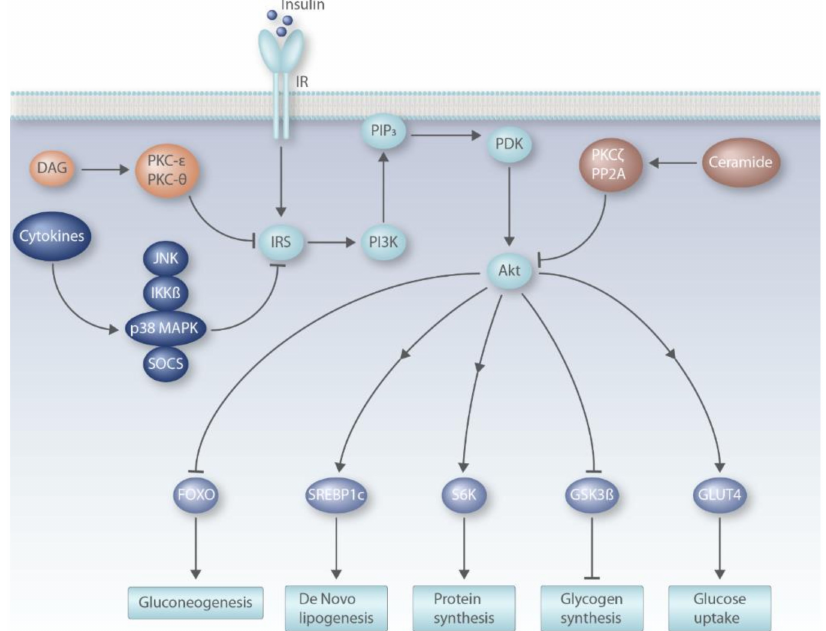
Figure 2. Molecular mechanisms of insulin actions and insulin resistance. DAG: diacylglycerol;